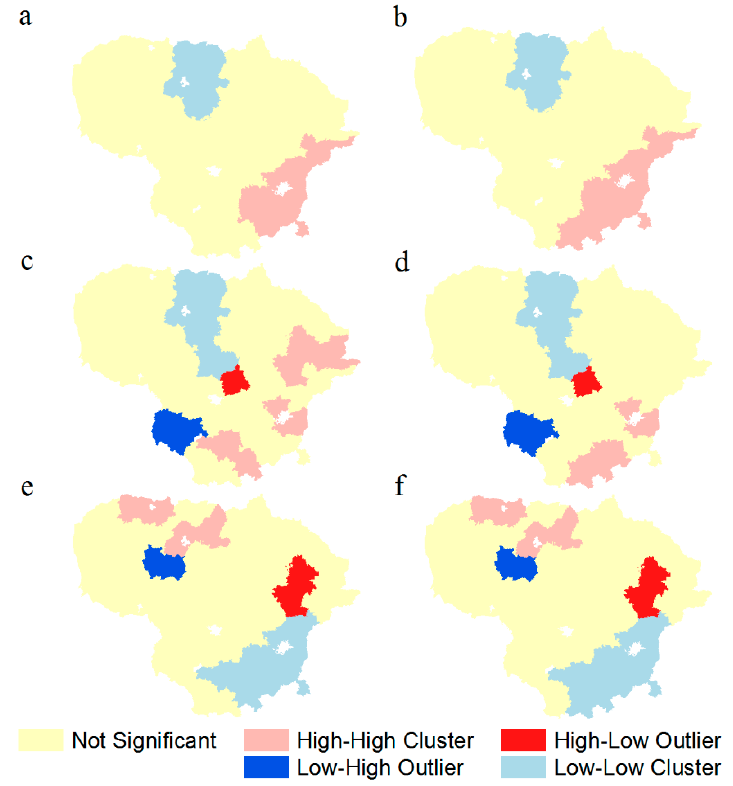
Figure 10. Hot spots, cold spots, and spatial outliers of climate change effects on selected key forestry attributes in Lithuanian forests during the next 100 years from 2020 to 2120: ( a ) Annual wood volume